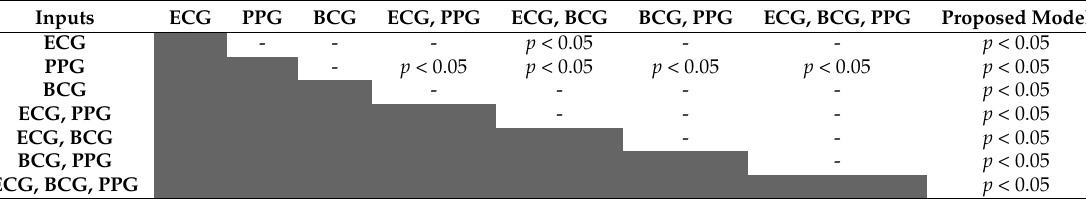
Table 6. Results of paired t -test between various inputs for DBP